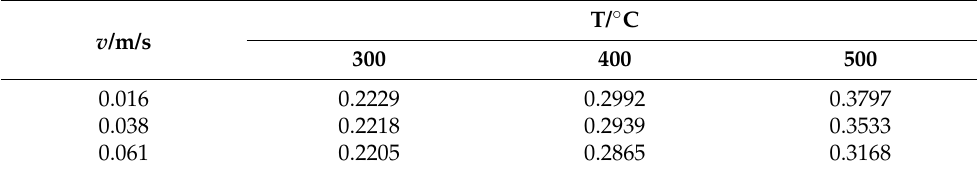
Table 6. Thermal deformation of steel joint when all threads are screwed (mm).